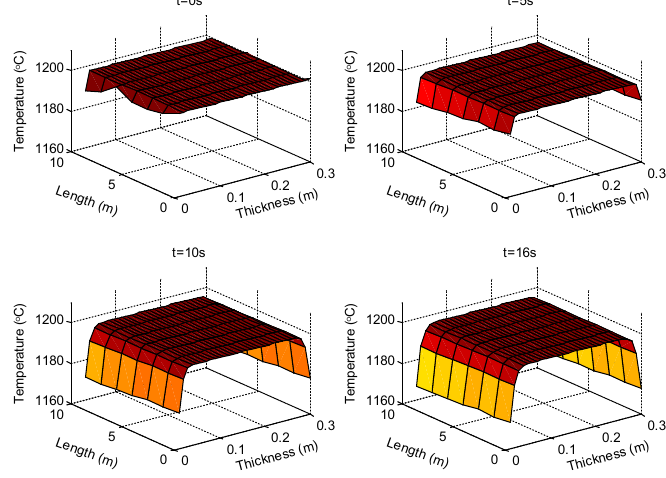
Figure 5. The estimated temperature distribution of the slab at different